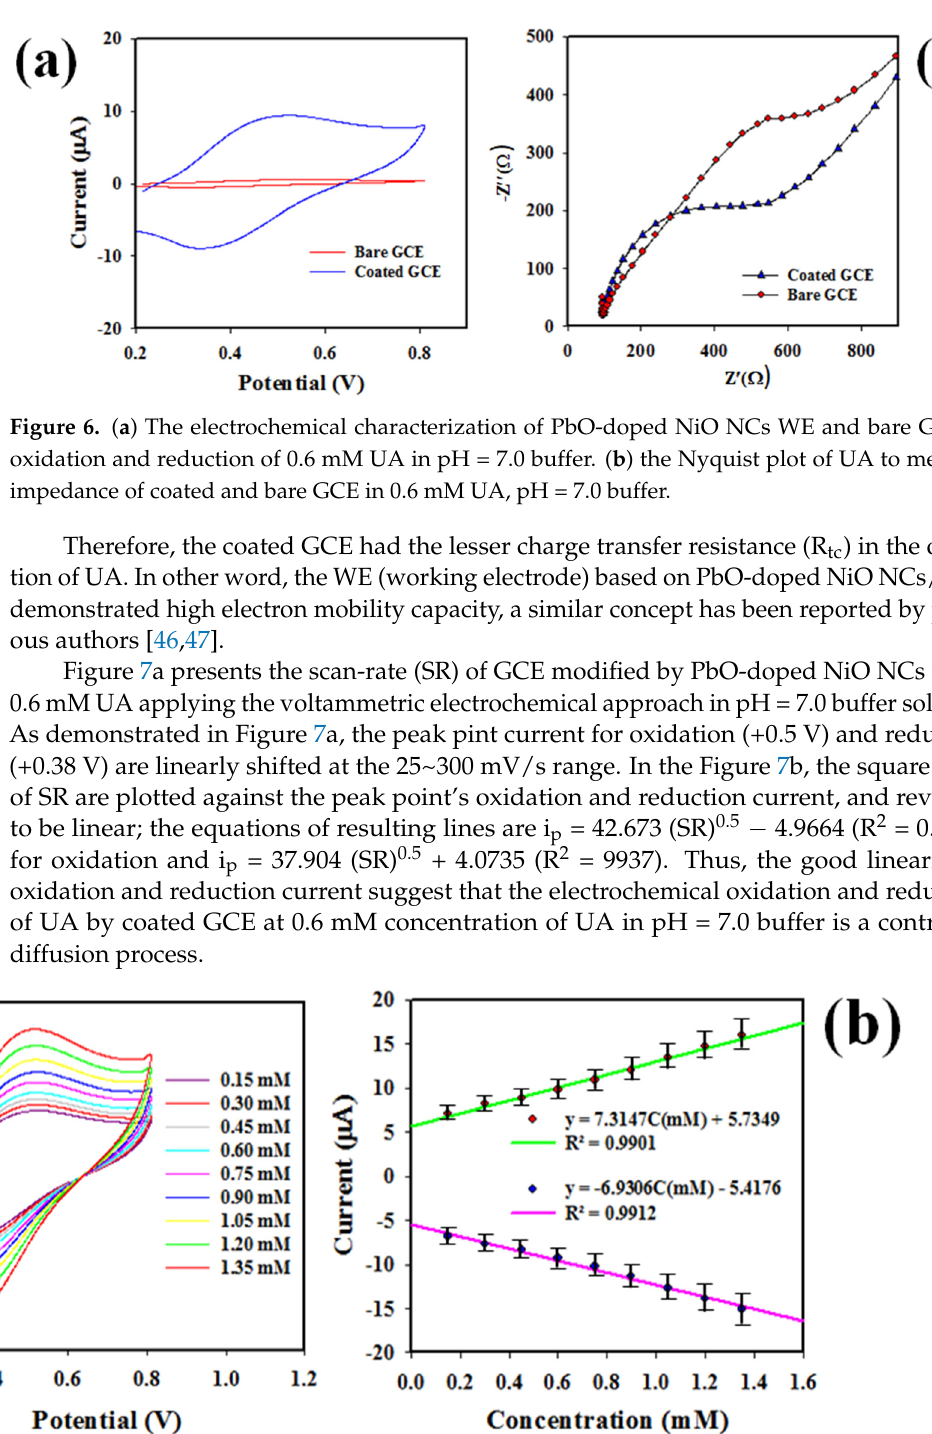
Figure 8. Detection of target chemicals with PbO-doped NiO NCs. ( a ) pH optimization DPV analysis of UA using PbO-doped NiO NCs/GCE electrode, ( b ) bar diagram of pH optimization, ( c ) DPV of UA based on modified GCE in buffer solution of pH 7.0, ( d ) calibration of UA sensor executed from peak current versus concentration of UA using the data from Figure 6c.